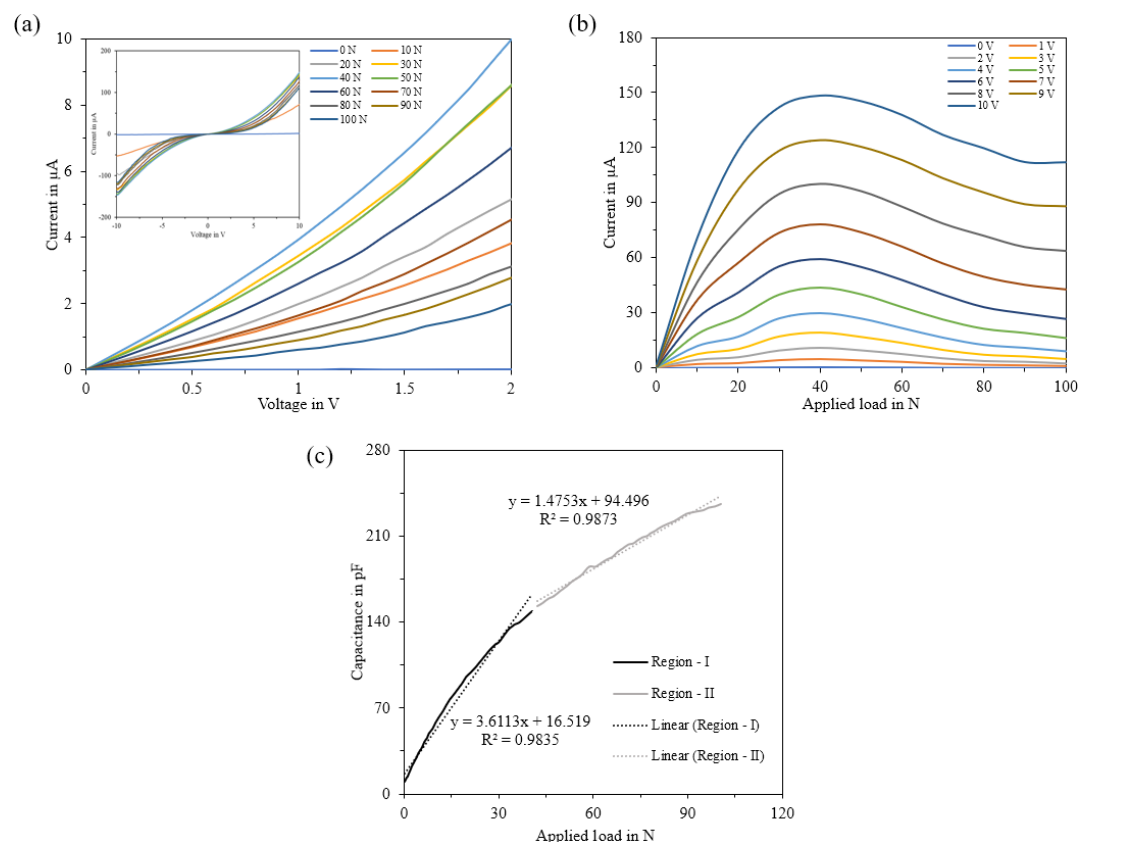
Figure 6. (a) Current-voltage characteristics for different loading conditions. (b) Current-pressure characteristics for different operating voltages. (c) Region of linearity in the sensor